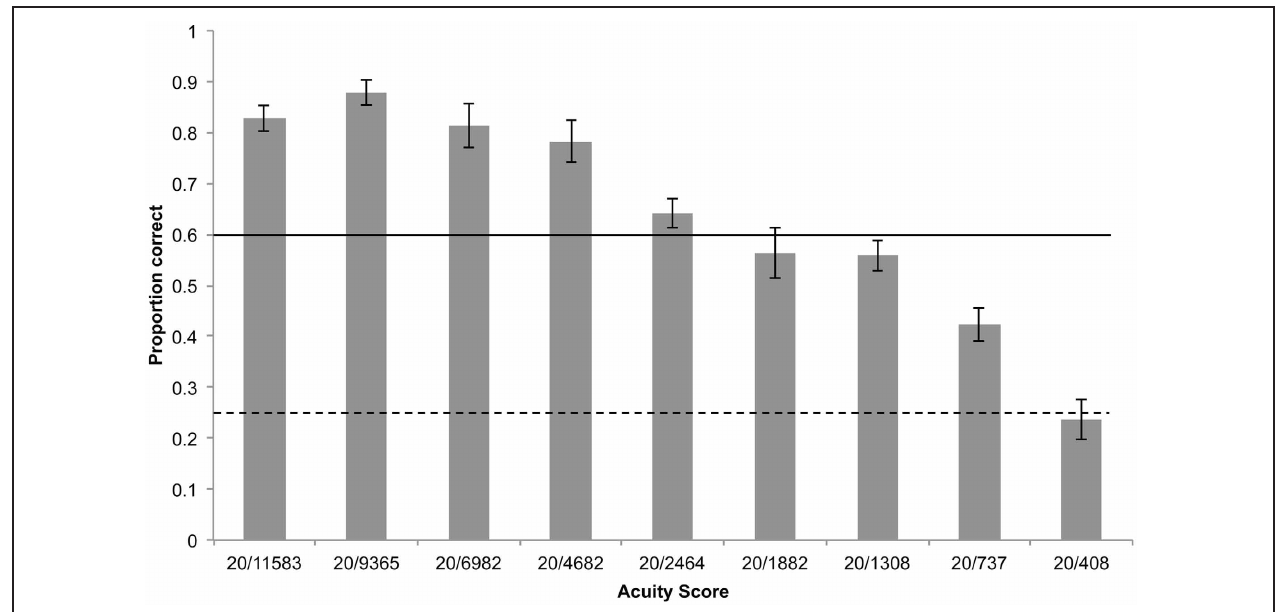
FIGURE 9 | Mean proportion of correctly identified optotype orientations using camera glasses by all participants for each block, shown on the X-axis as its corresponding acuity score. Error bars